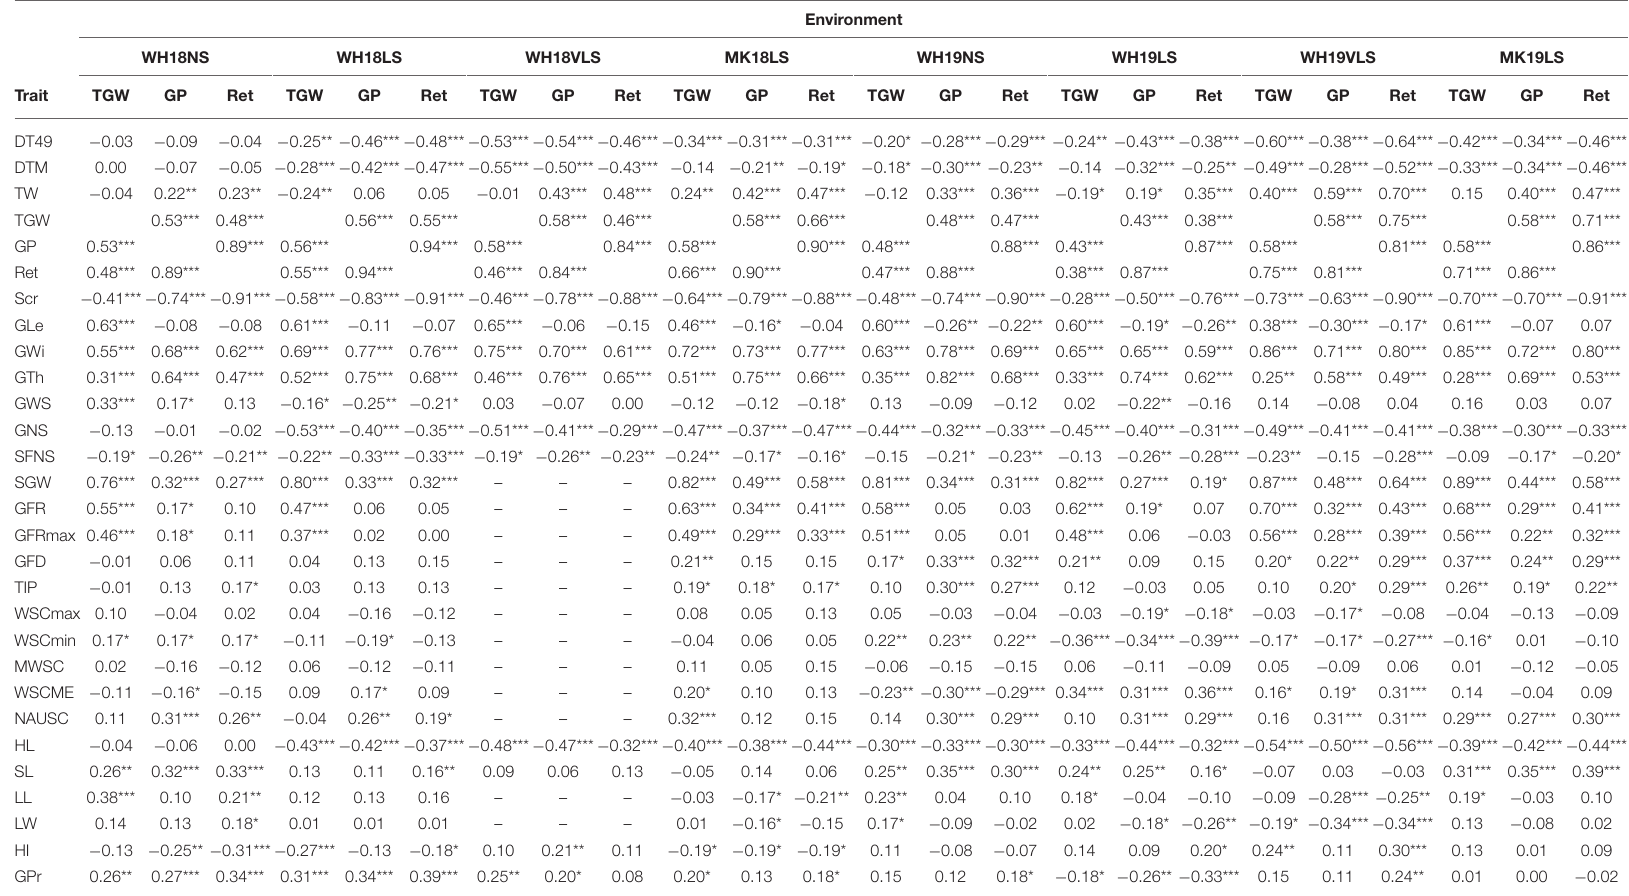
TABLE 3 | Correlations between thousand-grain weight (TGW), grain plumpness (GP), and retention (Ret), and traits measured in each